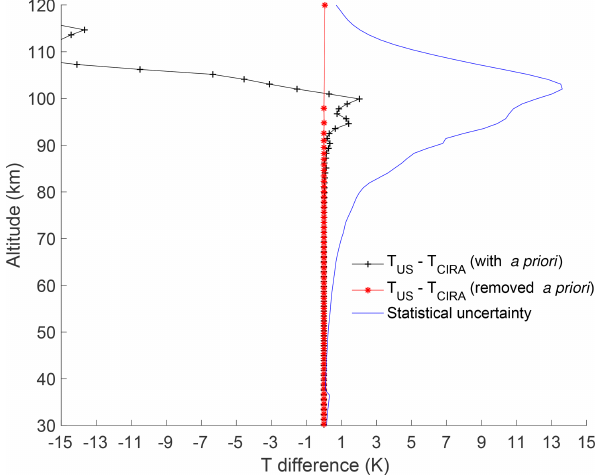
Figure 19. PCL temperature difference between the OEM retrieved temperature profiles using values from the US Standard Atmo- sphere and CIRA-86 as the a priori temperature